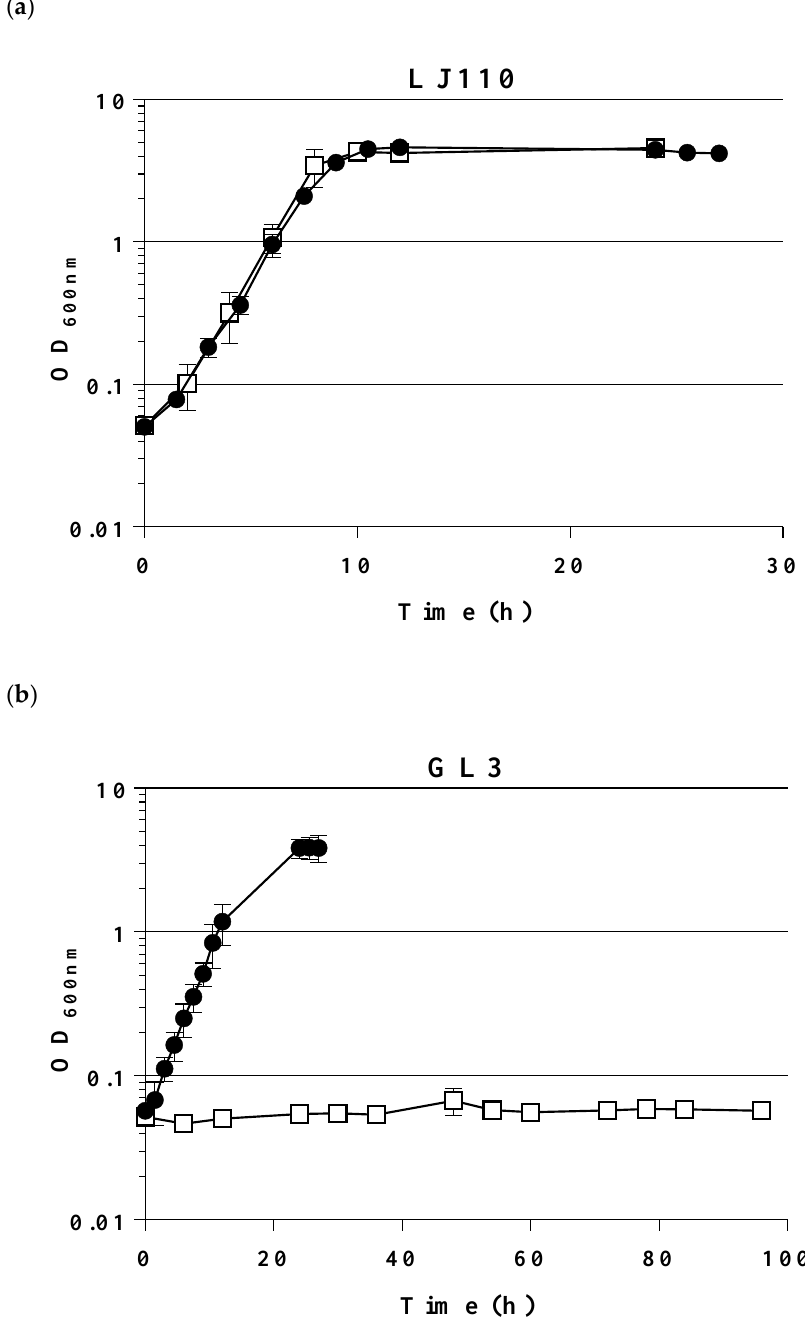
Figure 2. Growth behavior of wt LJ110 ( a ) and triple mutant strain, GL3 ( b ) on glucose or fructose as carbon sources. Shake flask growth on MM with fructose and 100 µ M IPTG ( • ) or on MM with glucose and 100 µ M IPTG ( (cid:3) ). At 37 ◦ C, 200 rpm. Average values of two biological replicates are presented. Both strains were inoculated from MM fructose overnight cultures. Note that the time axis is di ff erent in the two graphs. For details see Section